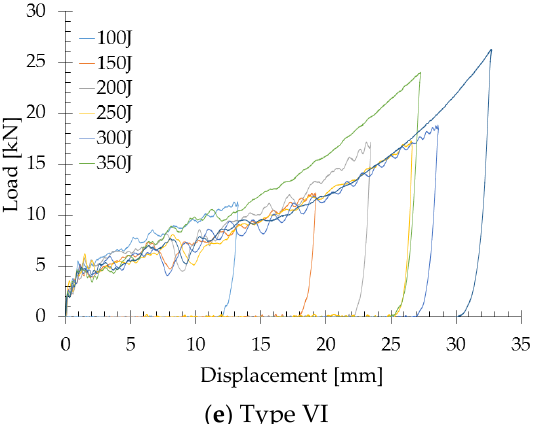
Figure 5. Load–displacement curves at different impact energies for each type of AF panels with and without aluminium skins.